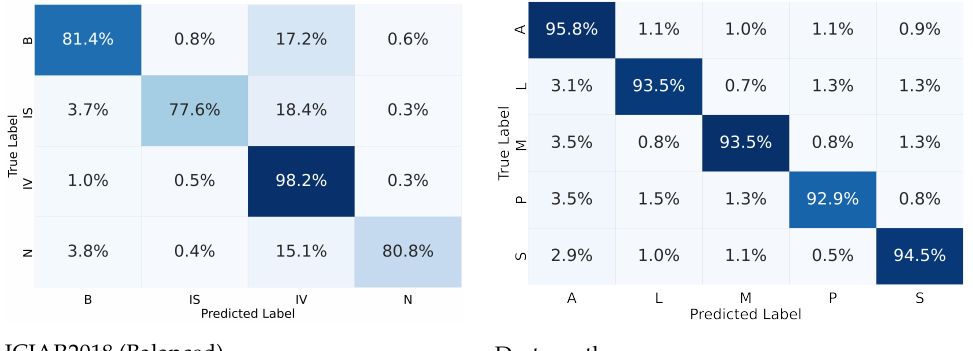
Figure 5. Confusion matrices for the multi-class classification of ICIAR2018 and Dartmouth datasets. Class labels are according to the abbreviations of Figures 2 and